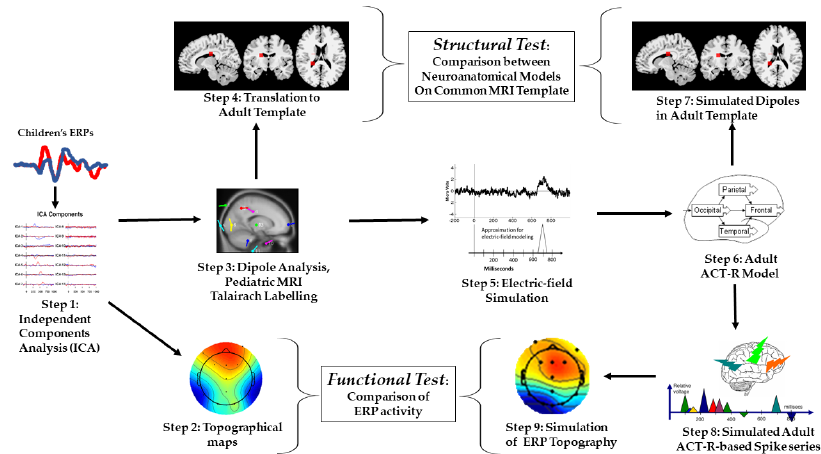
Figure 2. Process flow of the present study. Steps 1–4 describe modeling of actual children’s data; Steps 3–9 describe adult